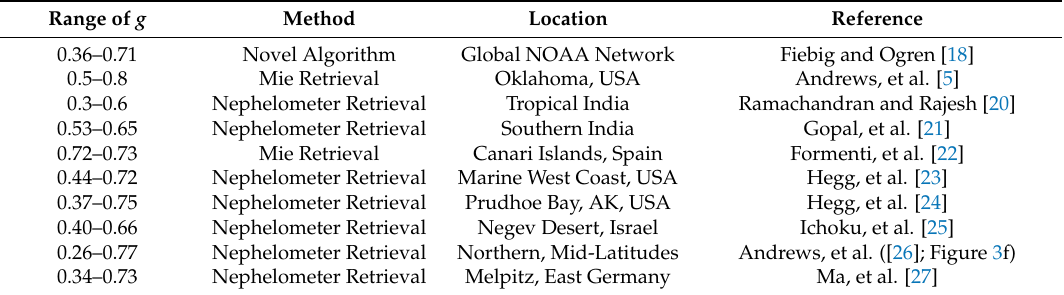
Table 1. Measurements of the Asymmetry Parameter g in the Ambient